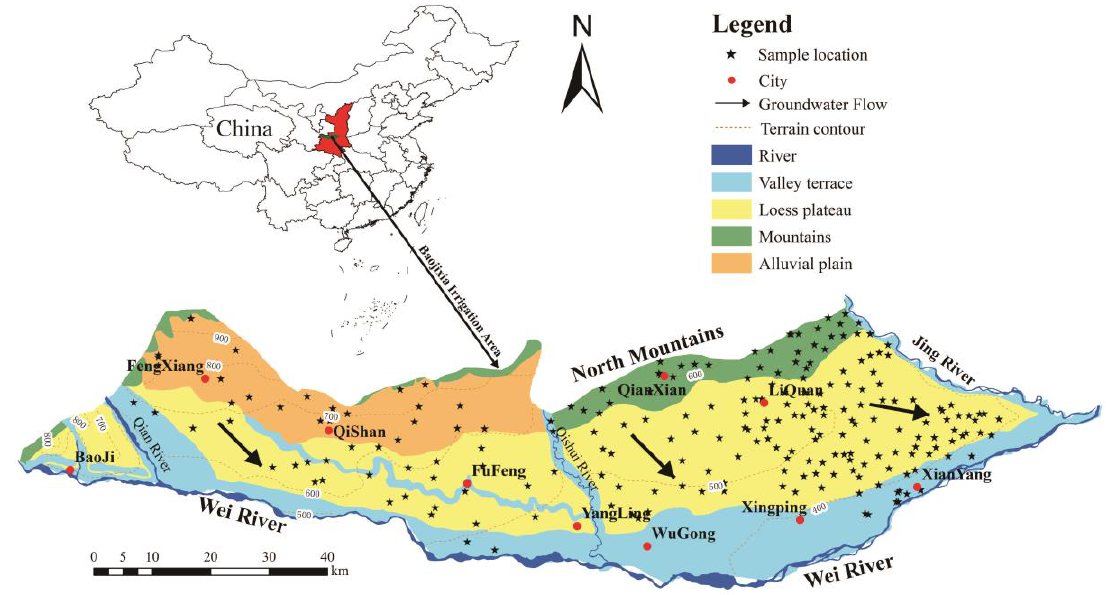
Figure 1. Study area and sampling locations.